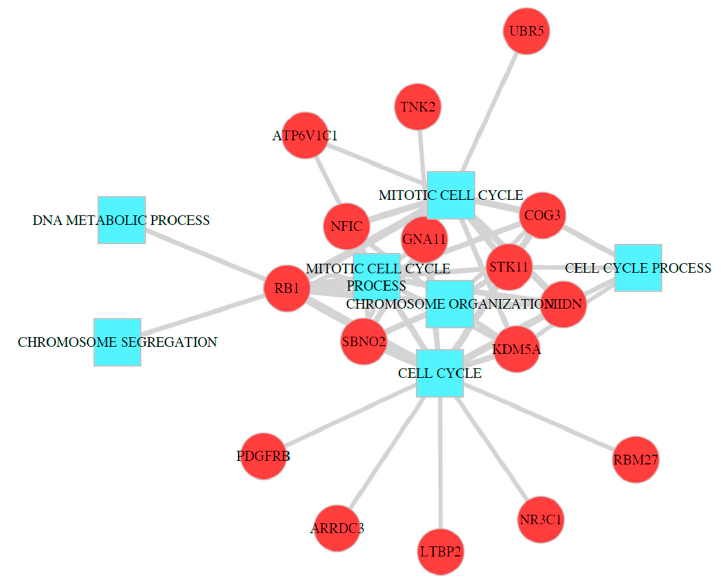
Figure 7. Results of meta-analysis of gene ontology enrichment analysis. The top 50 significant results are presented in a network of tumor suppressor gene (TSG) and gene ontology (GO) terms. Square nodes indicate GO terms, and the circular nodes represents corresponding TSGs. The width of edges is -log( p -value), and wider edges indicate more significant results.